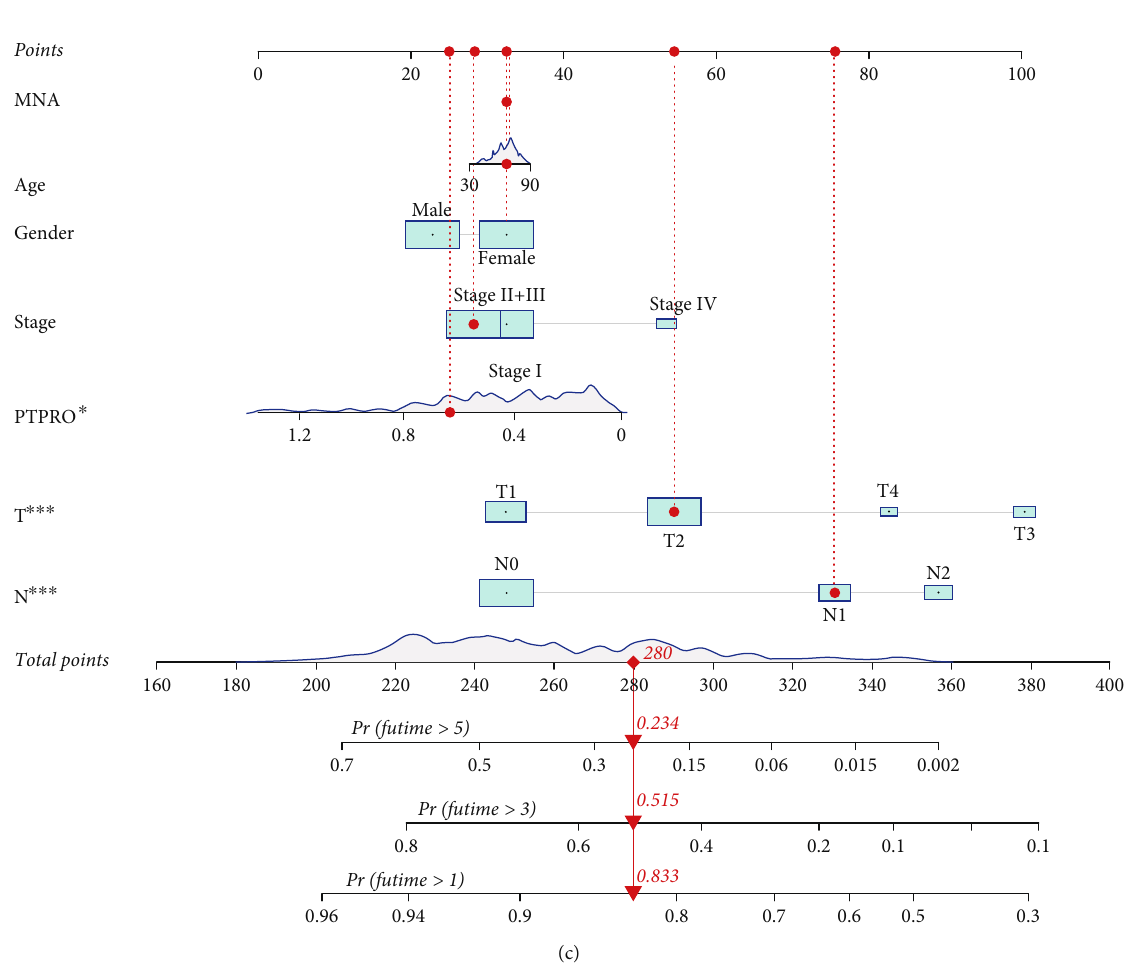
Figure 3: The value of PTPRO expression level in evaluating the prognosis of LUAD. (a, b) Univariate and multivariate regression analyses of PTPRO expression levels and clinical parameters. (c) Construction of nomogram by the PTPRO expression level and clinical characteristics for predicting the probability of 1-, 3-, and 5-year OS of LUAD